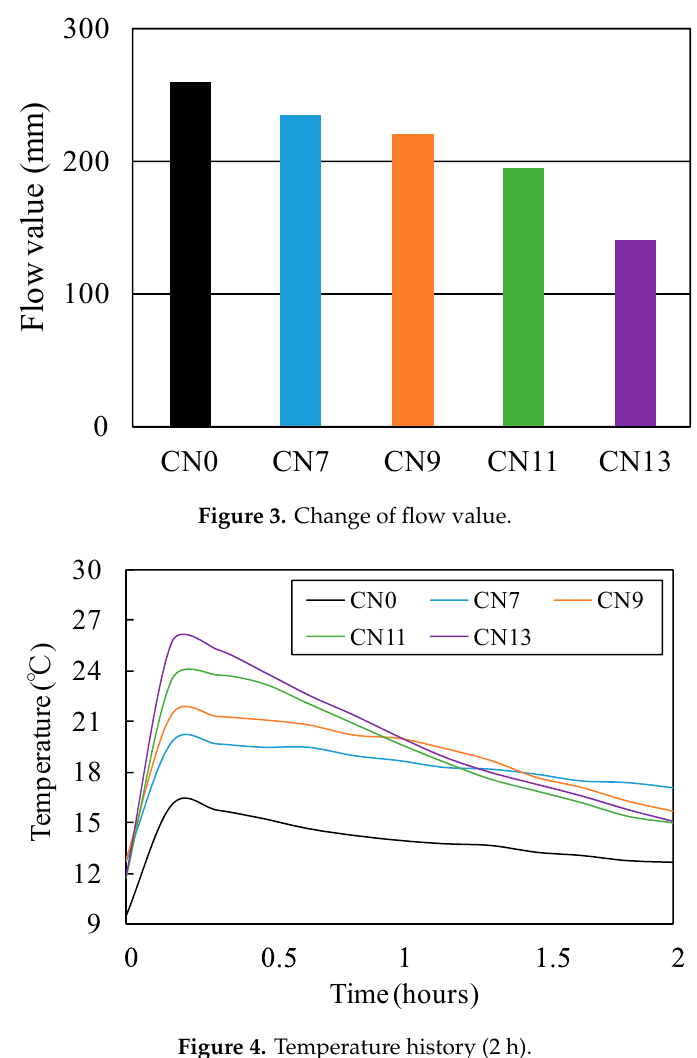
Figure 5. Compressive strength on Days 1 and 3.